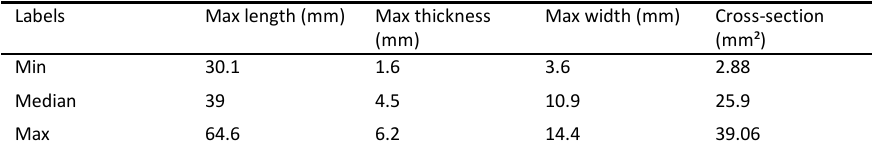
Table 12. Summary of the morphological variation in the identified projectile